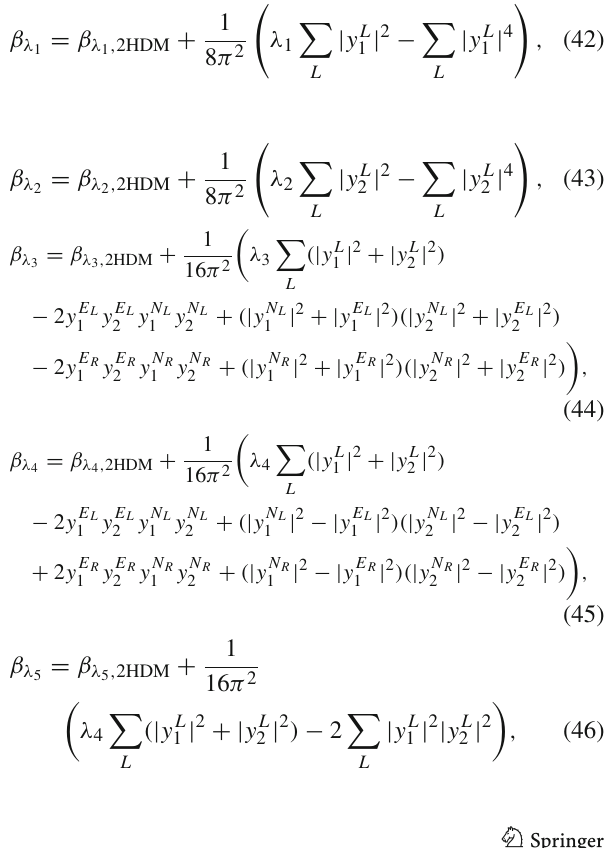
straints from EWPT disfavor mass degenerate H , A , H ± . We recall that, on the other hand, the variation of the masses of the Higgs states is constrained by perturbativity and unitarity limits, Eqs. (34) and (35). We have then reported on Fig. 5 the regions allowed by the latter constraints, determined by varying the input parameters of Eq. (29) over the same ranges considered in [66] (contrary to this reference we have